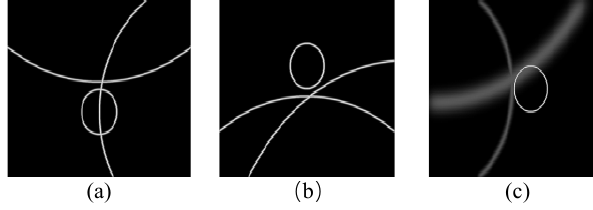
Figure 9 . Signal space score generated by different base station layouts for the same tag location. (a) A base station was at the same level as the tag. (b) Two base stations were on the same level as the tag. (c) Two base stations were on the same level with the tag, and the system error parameters were changed.